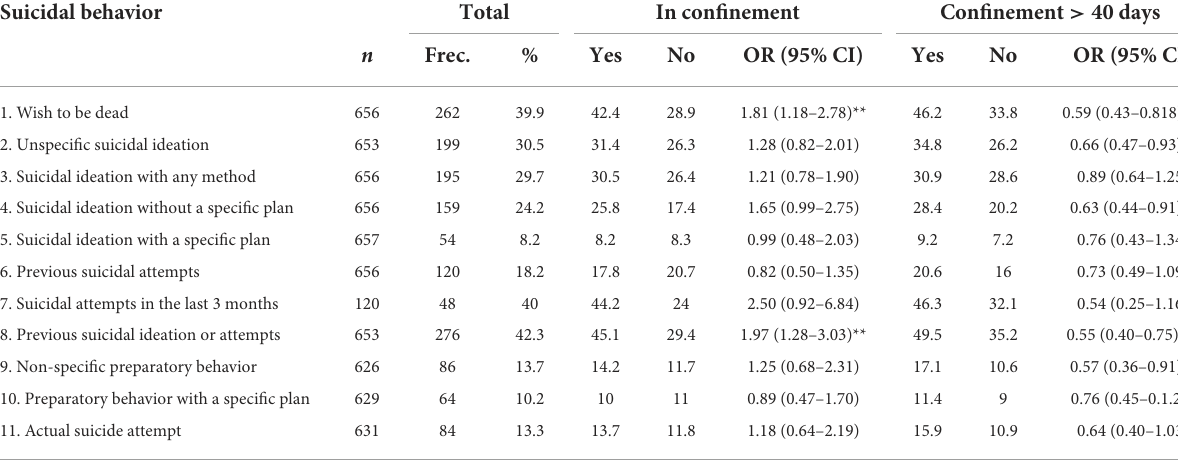
TABLE 6 Association between suicidal ideation and behavior in relation to confinement time. Suicidal